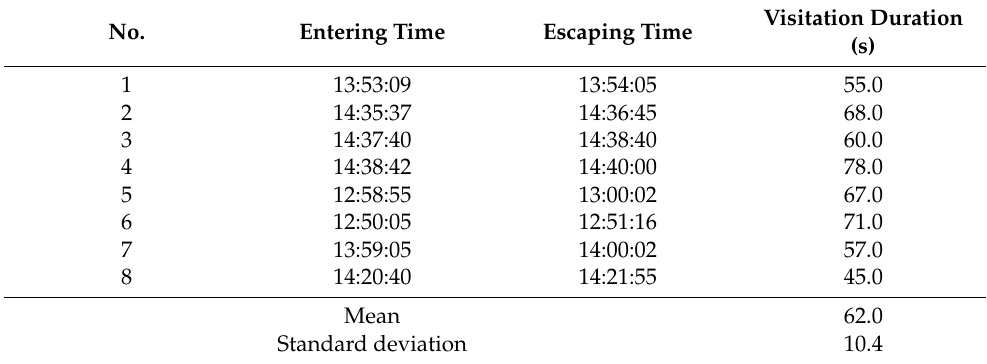
Table 2. Visitation duration of the effective pollinator Lasioglossum virideglaucum on Cypripedium guttatum . No.